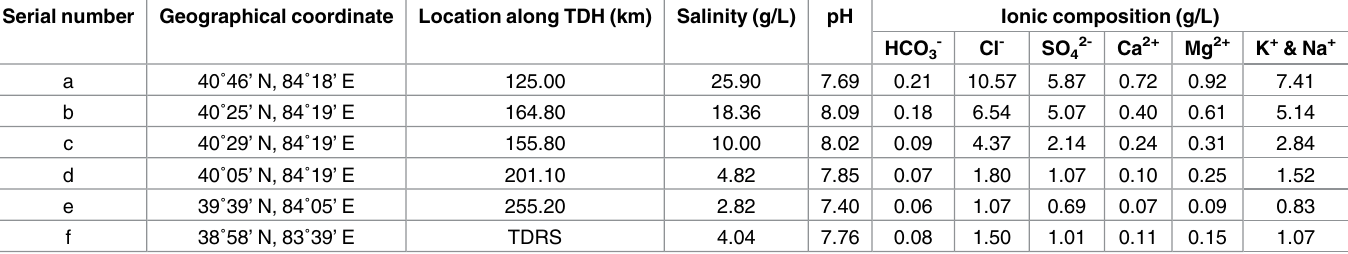
Table 2. Profiles of irrigation water quality of selected sites. Serial number Geographical coordinate Location along TDH (km) Salinity